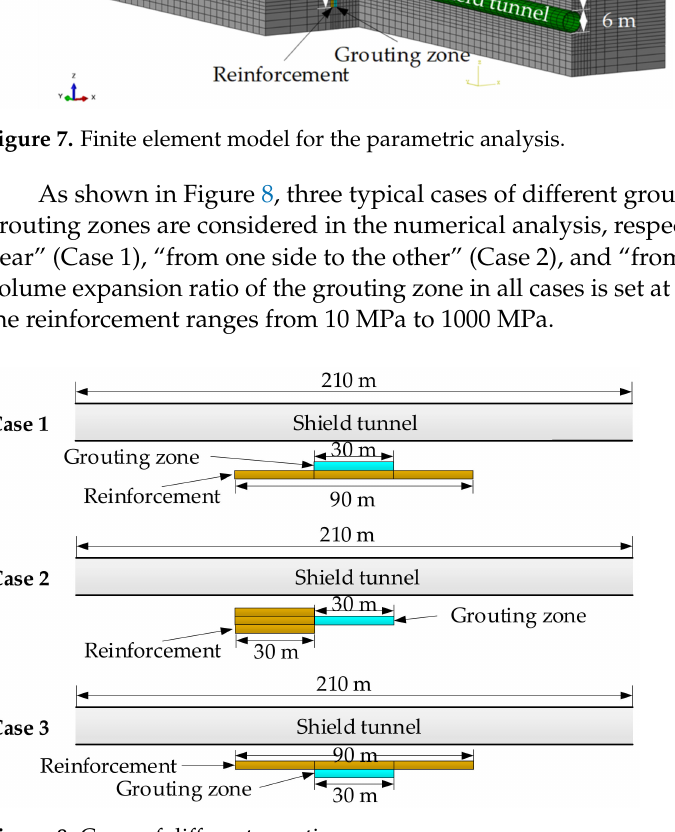
Figure 8. Cases of different grouting